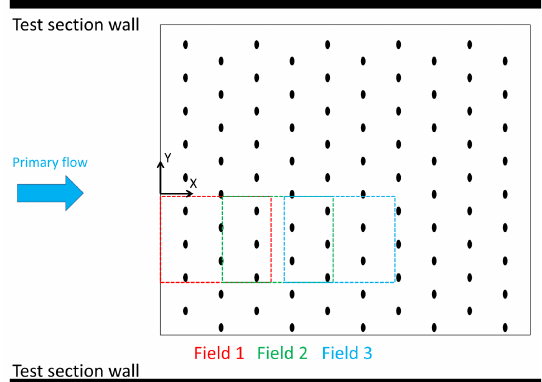
Figure 8. IRTh measurement